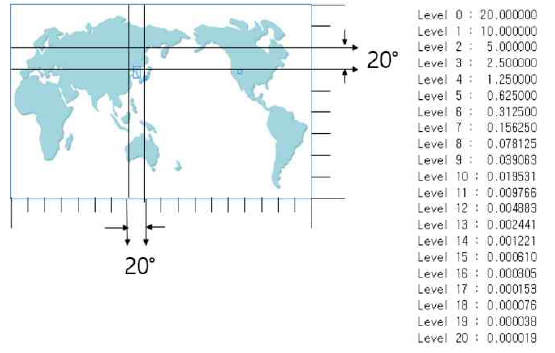
Figure 7. Tile degree for each level